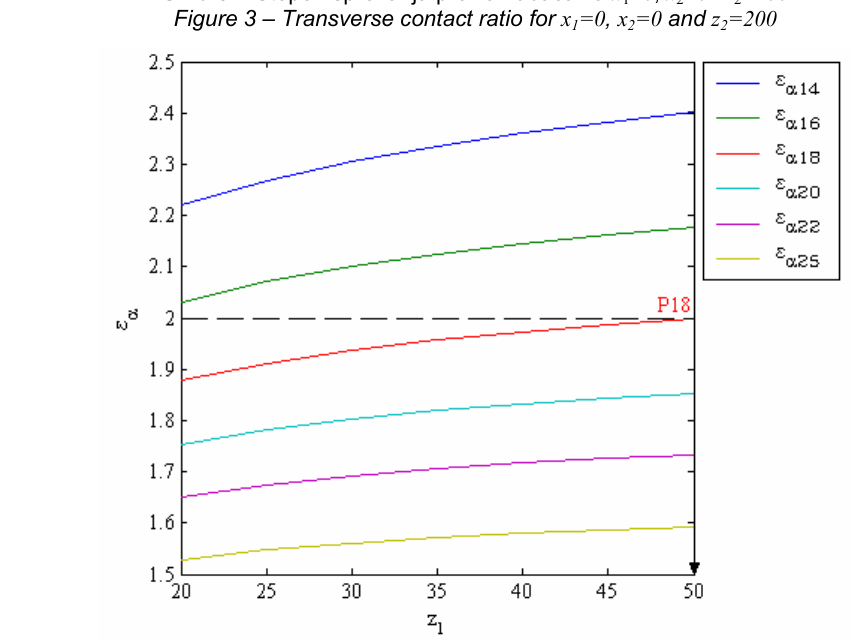
Figure 4 – Transverse contact ratio for x 1 =0 , x 2 =0 and z 2